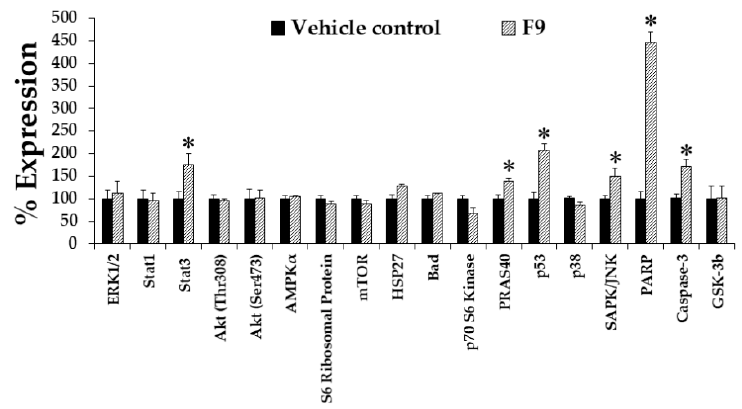
Figure 7. Effects of F9 on phosphor-kinase protein expressions in K562 cells after treating with 23.3 µg/mL for 48 h using a human phospho-kinase array kit. Asterisk (*) demonstrates statistically significant difference between the values of the vehicle control and the sample ( p < 0.05).